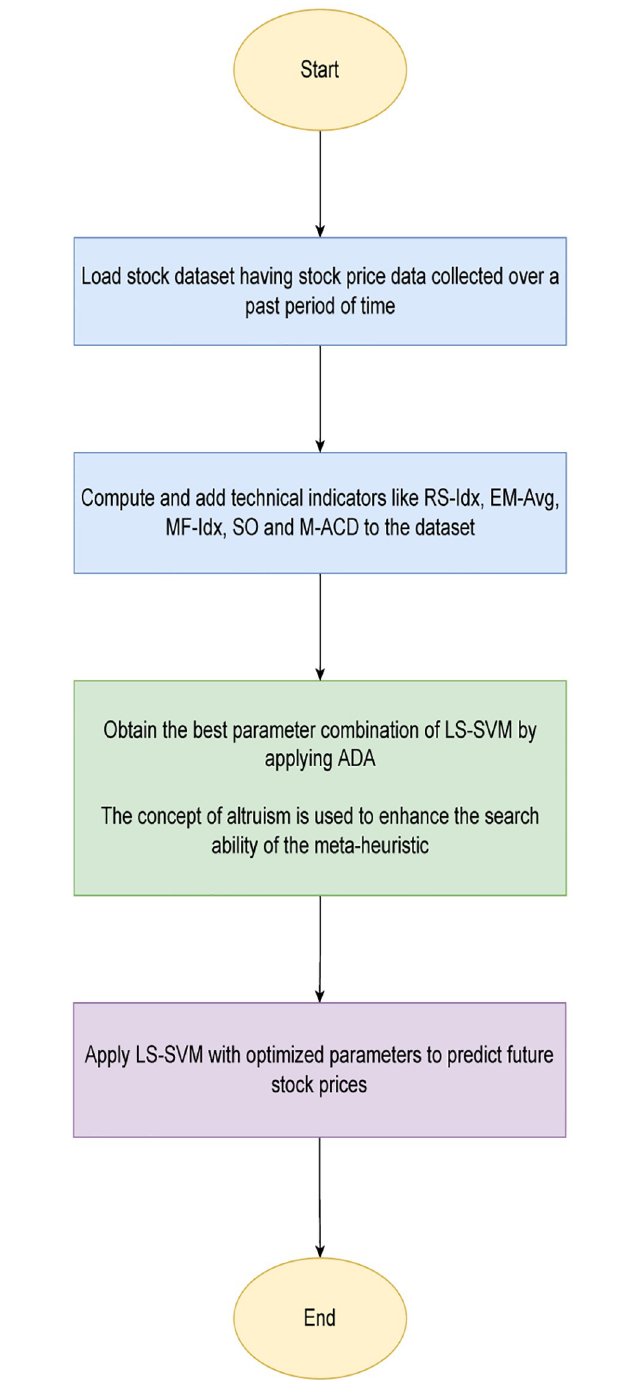
Fig 2. Flowchart describing the proposed model for predicting stock prices using LS-SVM optimized by ADA.